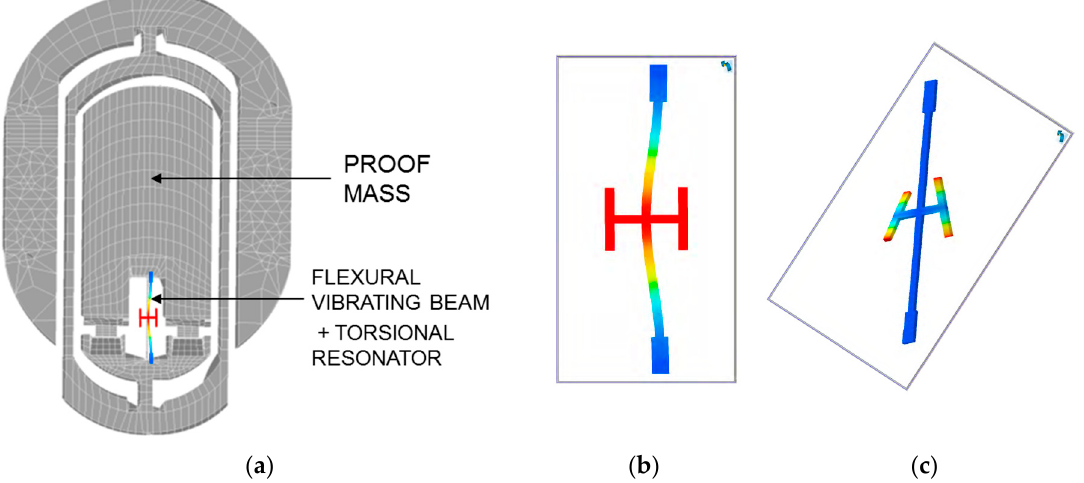
Figure 1. Vibrating beam accelerometer MEMS ( a ), flexural mode of the beam which eigen frequency is proportional to axial load induced by acceleration ( b ), torsional mode which eigen frequency is proportional to the beam temperature ( c ).